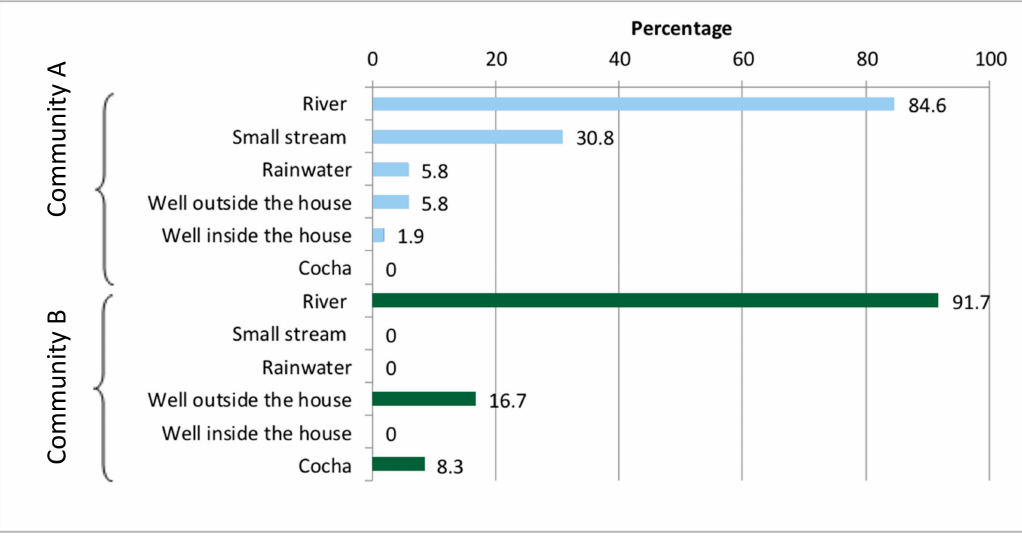
Figure 2. The water sources used for drinking, bathing, and washing, in each Shawi community in Yurimaguas, Armanayacu River and basin,